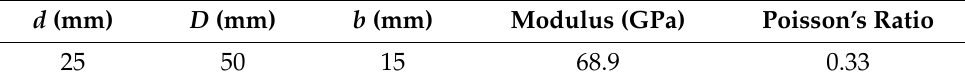
Figure 11. Experimental setup of diametrical compression test.